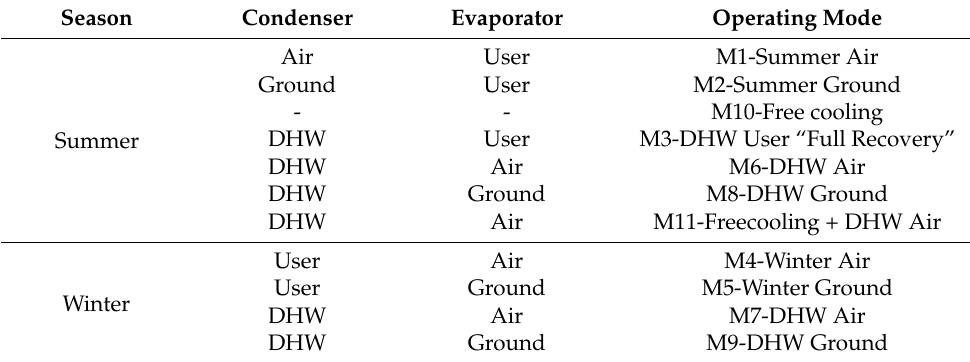
Table 1. DSHP system operating